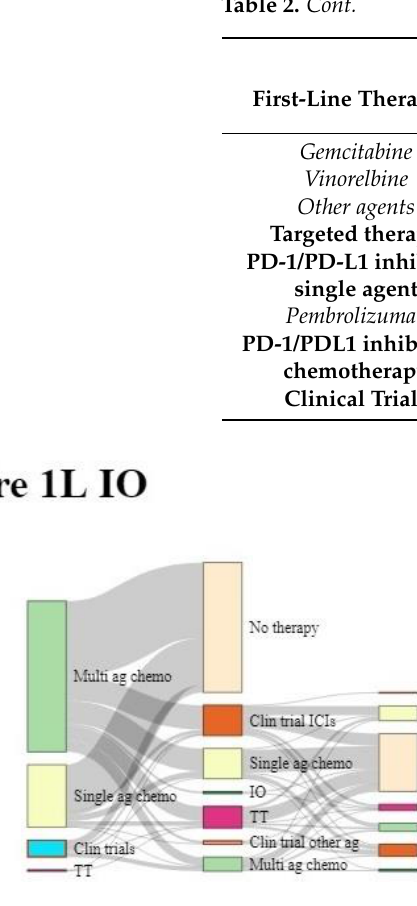
Figure 2. Treatment patterns across lines of therapy for Pre- and Post-1L IO cohorts. Each Sankey node represents a line of therapy, from 1L to 3L. The width of each group in each node was propor- tional to the number of patients. Possible reasons for not receiving 2L and 3L treatment include death, still receiving 1L or 2L treatment and patient preference. Multi ag chemo = multi-agents chemotherapy; single ag chemo = single-agent chemotherapy; clin trial = clinical Trials; TT = targeted therapy; no therapy = no further therapy, clin trial ICIs = clinical trial with ICIs agent; IO = immuno- oncology; clin trial other ag = clinical trial with other agents different from IO; IO + chemo = im- muno-oncology+ chemotherapy